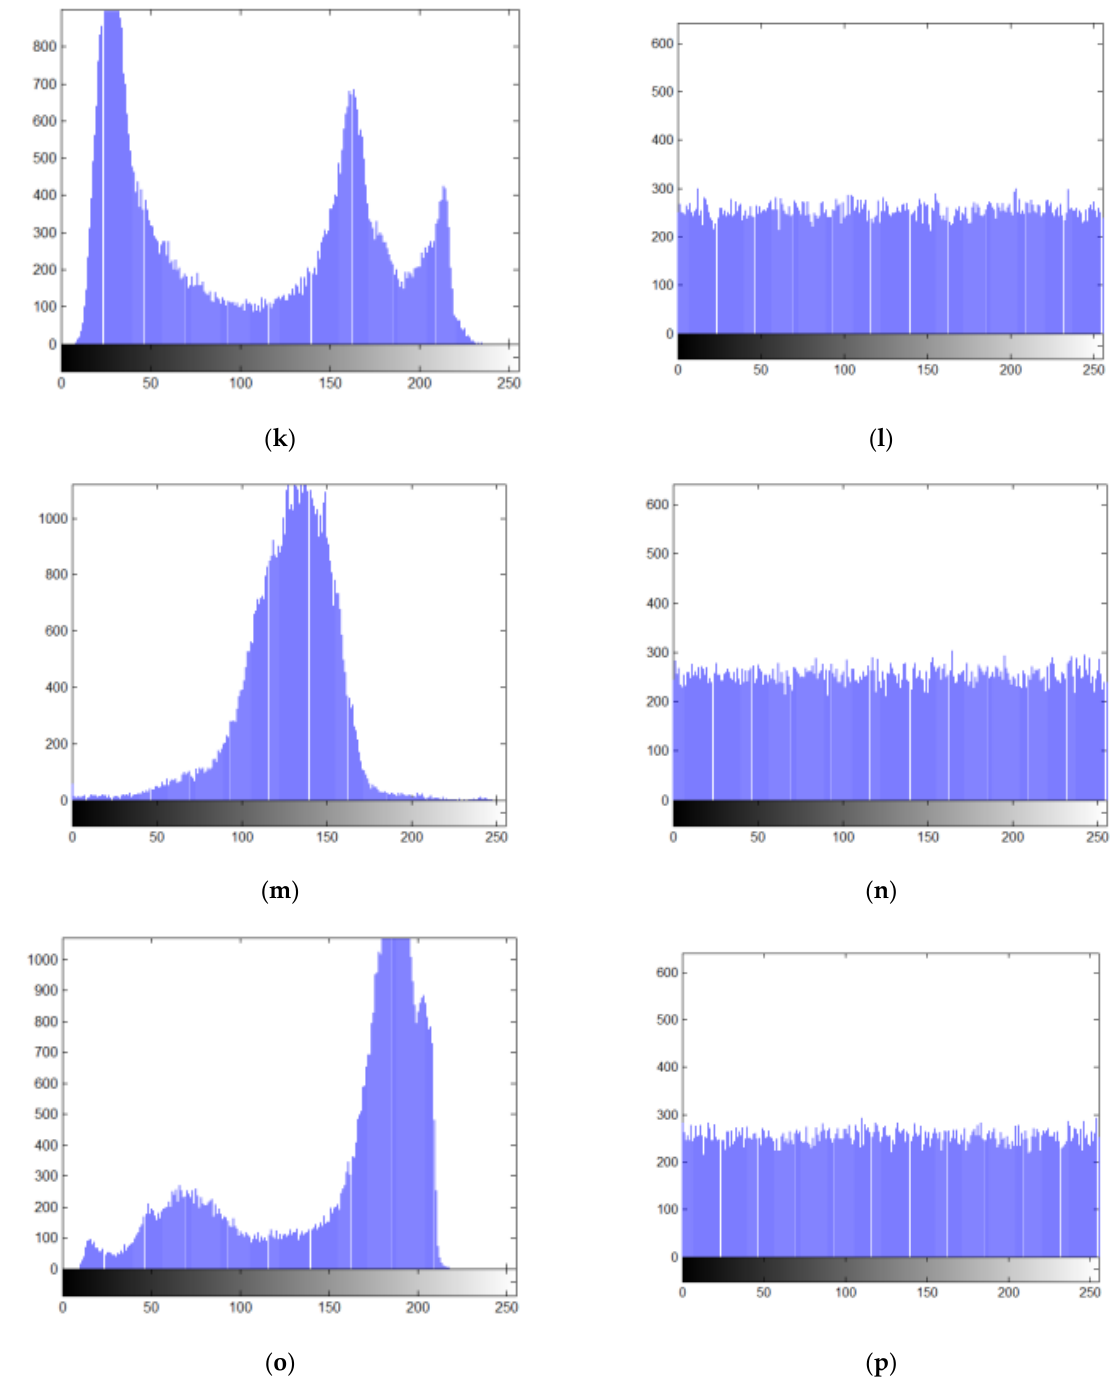
Figure 8. Histograms of the magnitude of the plaintext and encrypted images. ( a ) Lena; ( b ) ciphered Lena; ( c ) Boat; ( d ) ciphered Boat; ( e ) Cameraman; ( f ) ciphered Cameraman; ( g ) Peppers; ( h ) ciphered Peppers; ( i ) House; ( j ) ciphered House; ( k ) Lake; ( l ) ciphered Lake; ( m ) Moon surface; ( n ) ciphered Moon surface; ( o ) Plane; ( p ) ciphered Plane.